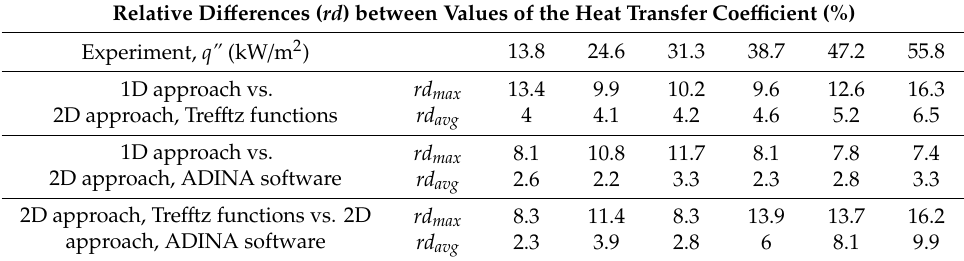
Table 6. The values of the maximum ( rd max ) and the average ( rd avg ) relative di ff erences between heat transfer coe ffi cients obtained using the 1D approach and the 2D approach (applying the Tre ff tz functions and ADINA software), the data for the test section with five